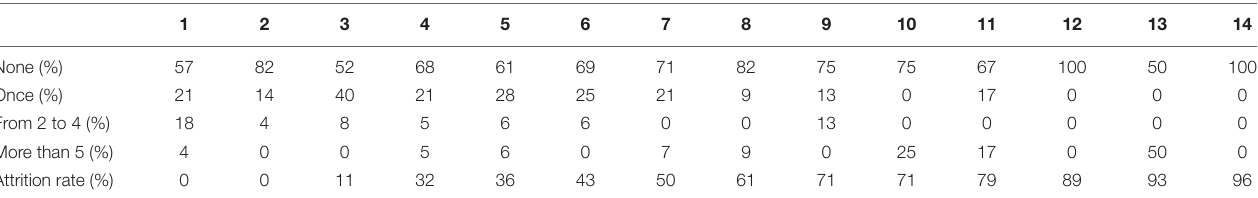
TABLE 1 | Relative frequencies and attrition